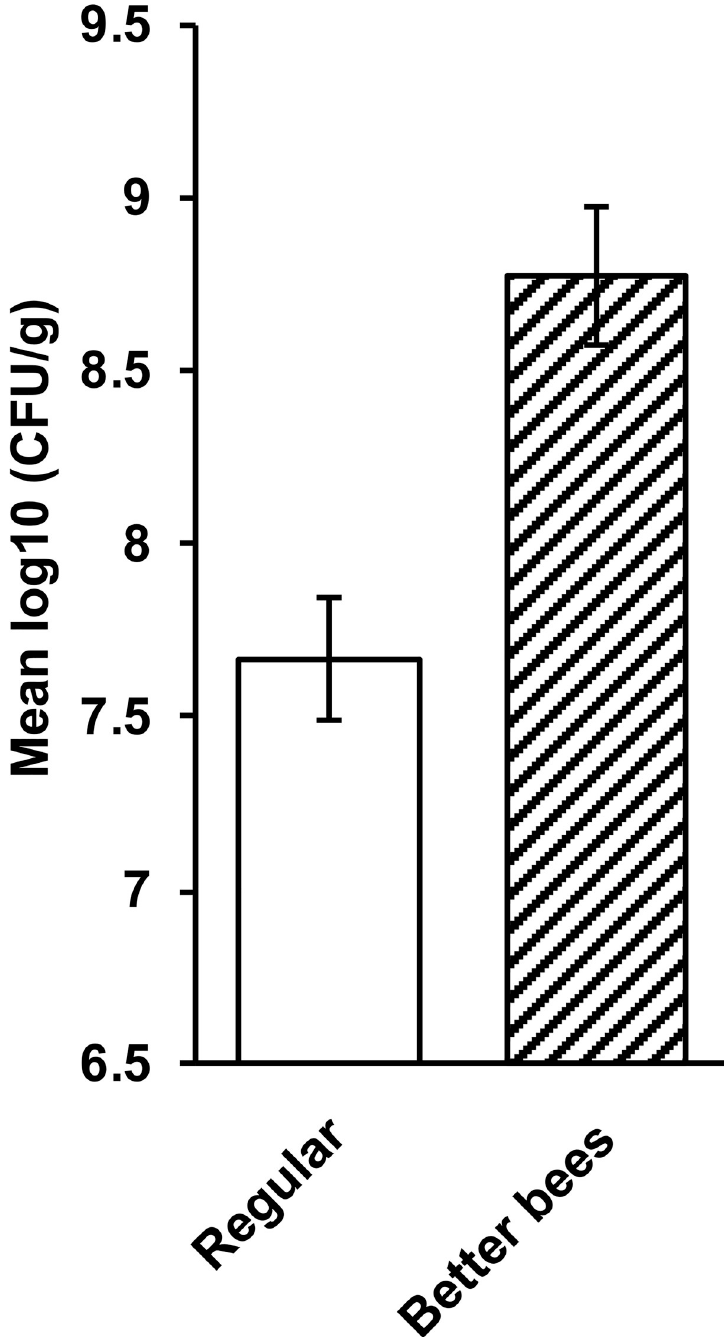
Fig 4. Aerobic gut bacterial numbers (CFU/g) in healthy nurse bees from “Better Bee” colonies ( n = 10) and bees from regular breeding colonies ( n = 10). All bees were collected from apiaries in Western Australia. The difference between the two groups is statistically significant ( P = 0.002). Error bars represent the SEM with a 5% least significant difference (LSD) level of 0.562. Of the 1,758 aerobic bacterial isolates from the gut of healthy bees, only 170 strongly inhib- ited the chalkbrood fungus (% inhibition, � 30%; for examples without and with anti-fungal activity, see Fig 6A and 6B, respectively). A genetic analysis using randomly amplified